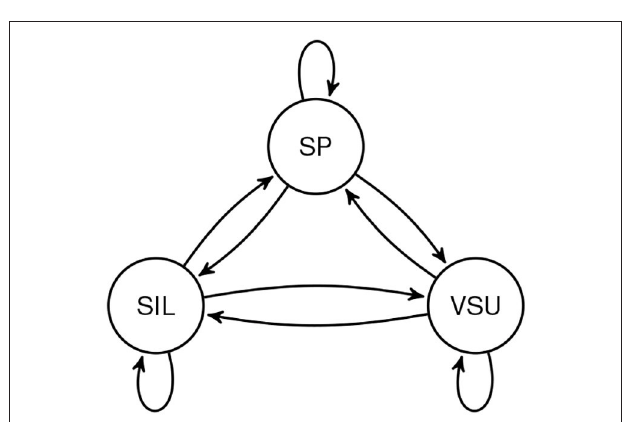
FIGURE 11 | The turn-taking/respiratory model from Włodarczak and Heldner (2016b) showing all possible transitions between respiratory cycle types: speech (SP), very short utterance (VSU), and silent